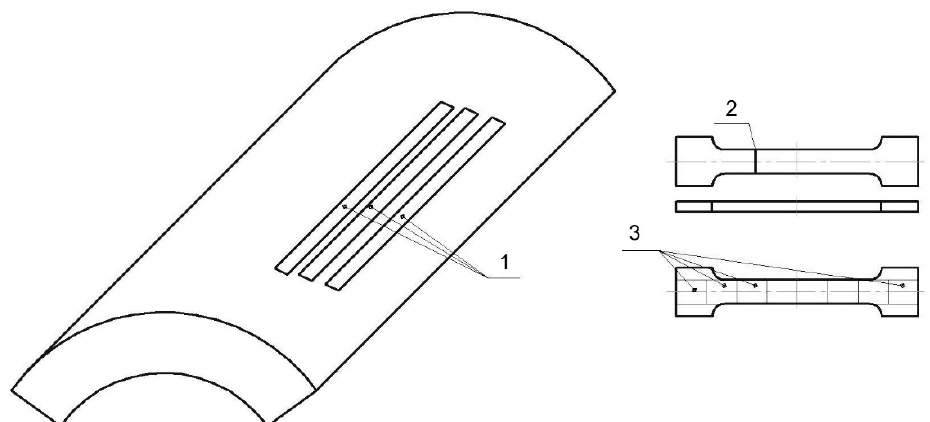
Figure 1. Schematic representation of sections of pipe zones made of the investigated steels, in which the structure was studied: 1—samples for mechanical tests, 2—conditional zone of localization of deformations; 3—areas for measuring the parameters of non-destructive tests (delay time ( R , ns), attenuation coefficient ( K att , 1/ µ s) and amplitude swing of the received signal ( A , 1/mm) of the surface acoustic wave, magnetic noise intensity ( MNI , d/q).